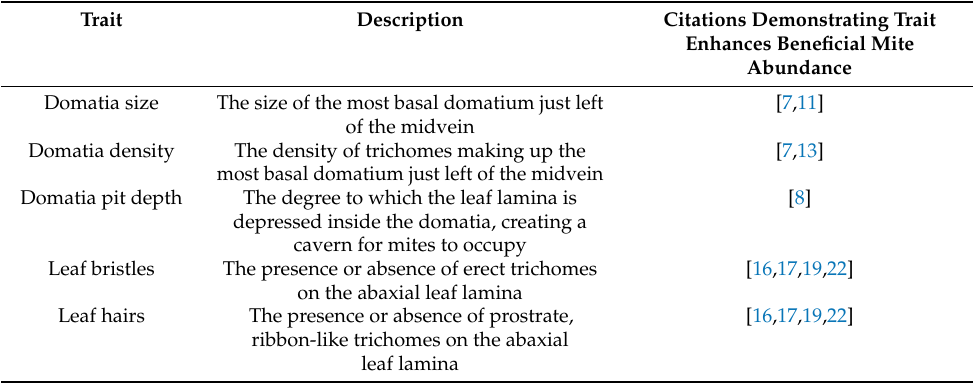
Table 1. The phenotypes used in this study and associated citations supporting their role in mediating beneficial mite populations. All cited papers present research conducted on Vitis , with the exception of [8], which is focused on Cinnamomum camphor . Additional details on measurements can be found in the